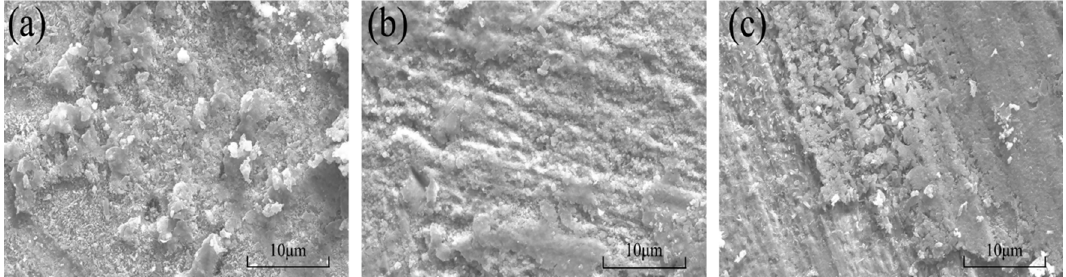
Figure 7. SEM images after peeling off the coatings: ( a ) CSA@POT coating; ( b ) 3-MG/CSA@POT coating; ( c ) 5-MG/CSA@POT coating.